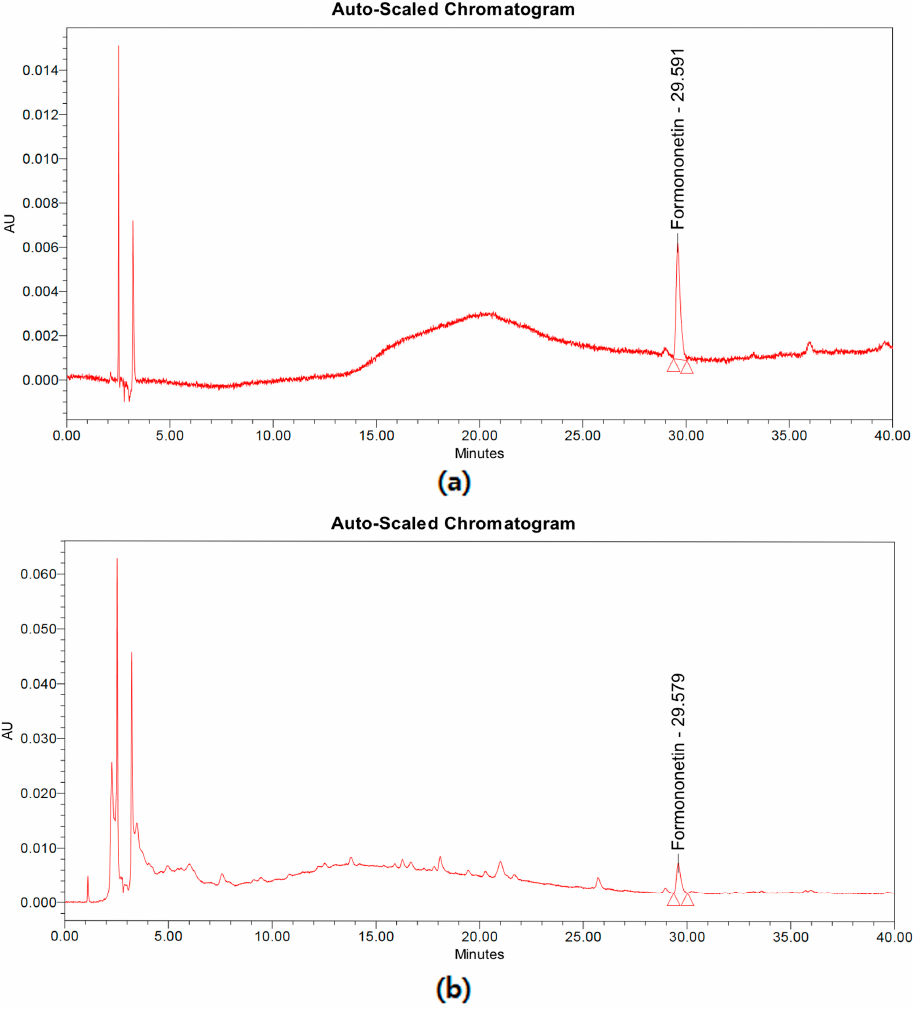
Figure 1. Chromatogram of formononetin and Spatholobus suberectus extract. ( a ) Chromatogram of formononetin standard compounds. ( b ) Chromatogram of S. suberectus extract.